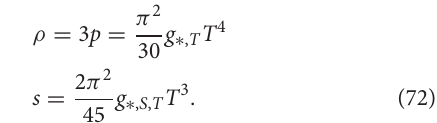
FIGURE 4 | Relic density of the axi-Higgs as a function of tan β for several values of the mass of the axi-Higgs.